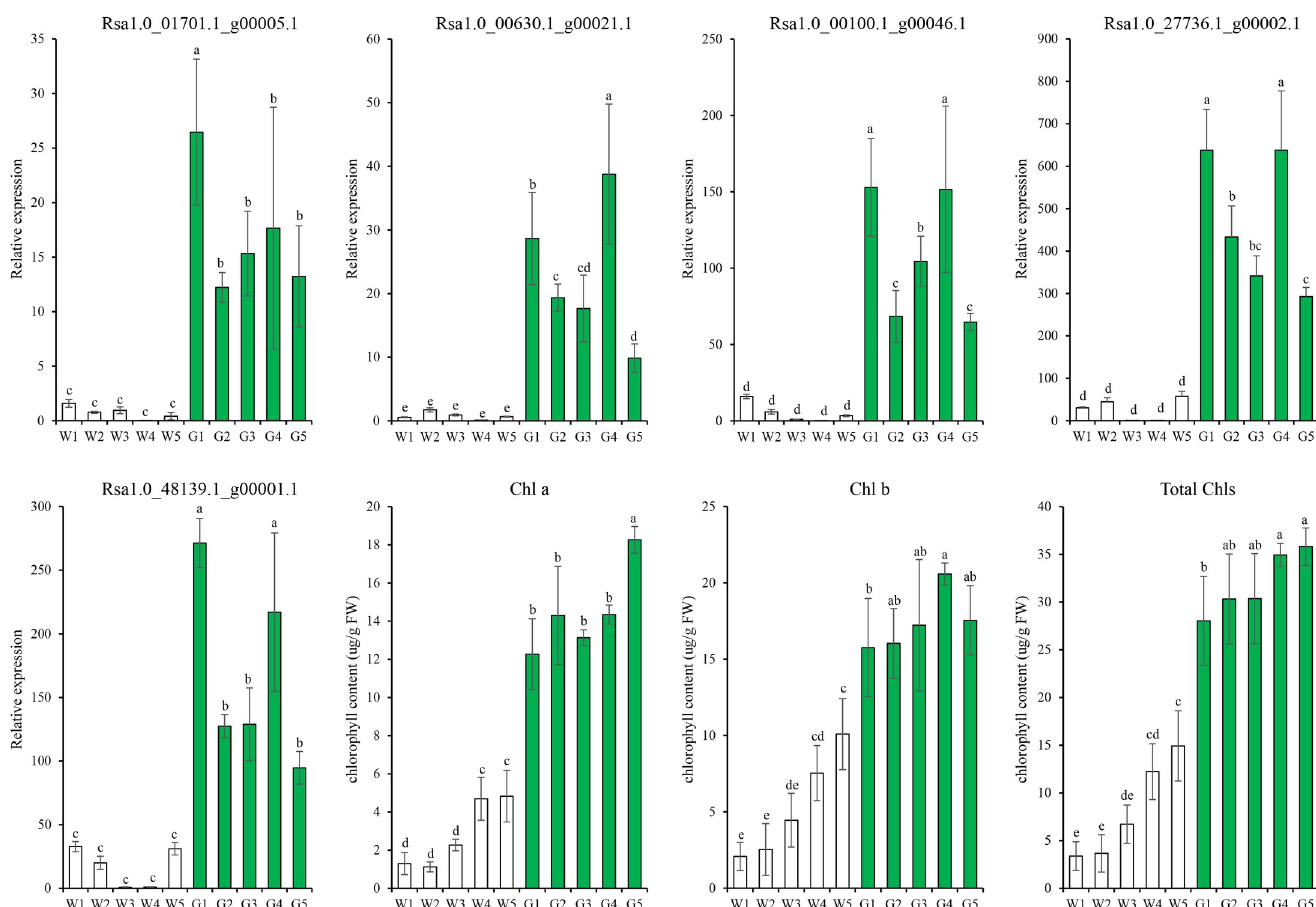
Fig 10. qRT-PCR expression of five candidate genes involved in part Ⅳ of chlorophyll biosynthesis and chlorophyll content in ten radish cultivars. Different letters indicate significant differences at P � 0.05. W1-W5, white-fleshed radish cultivars; G1-G5, green-fleshed radish cultivars.